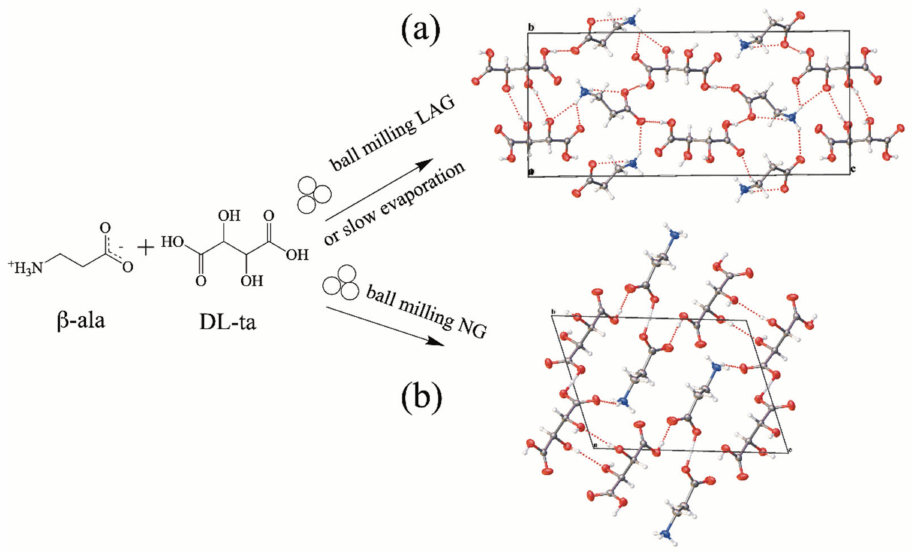
Figure 12. Formation of different multicomponent solid forms ( β -ala + DL-ta; 1:1) depending on the synthetic method used: ( a ) cocrystal (plane bc ; CSD refcode: VELBIA) and ( b ) multicomponent salt (plane bc ; CSD refcode: